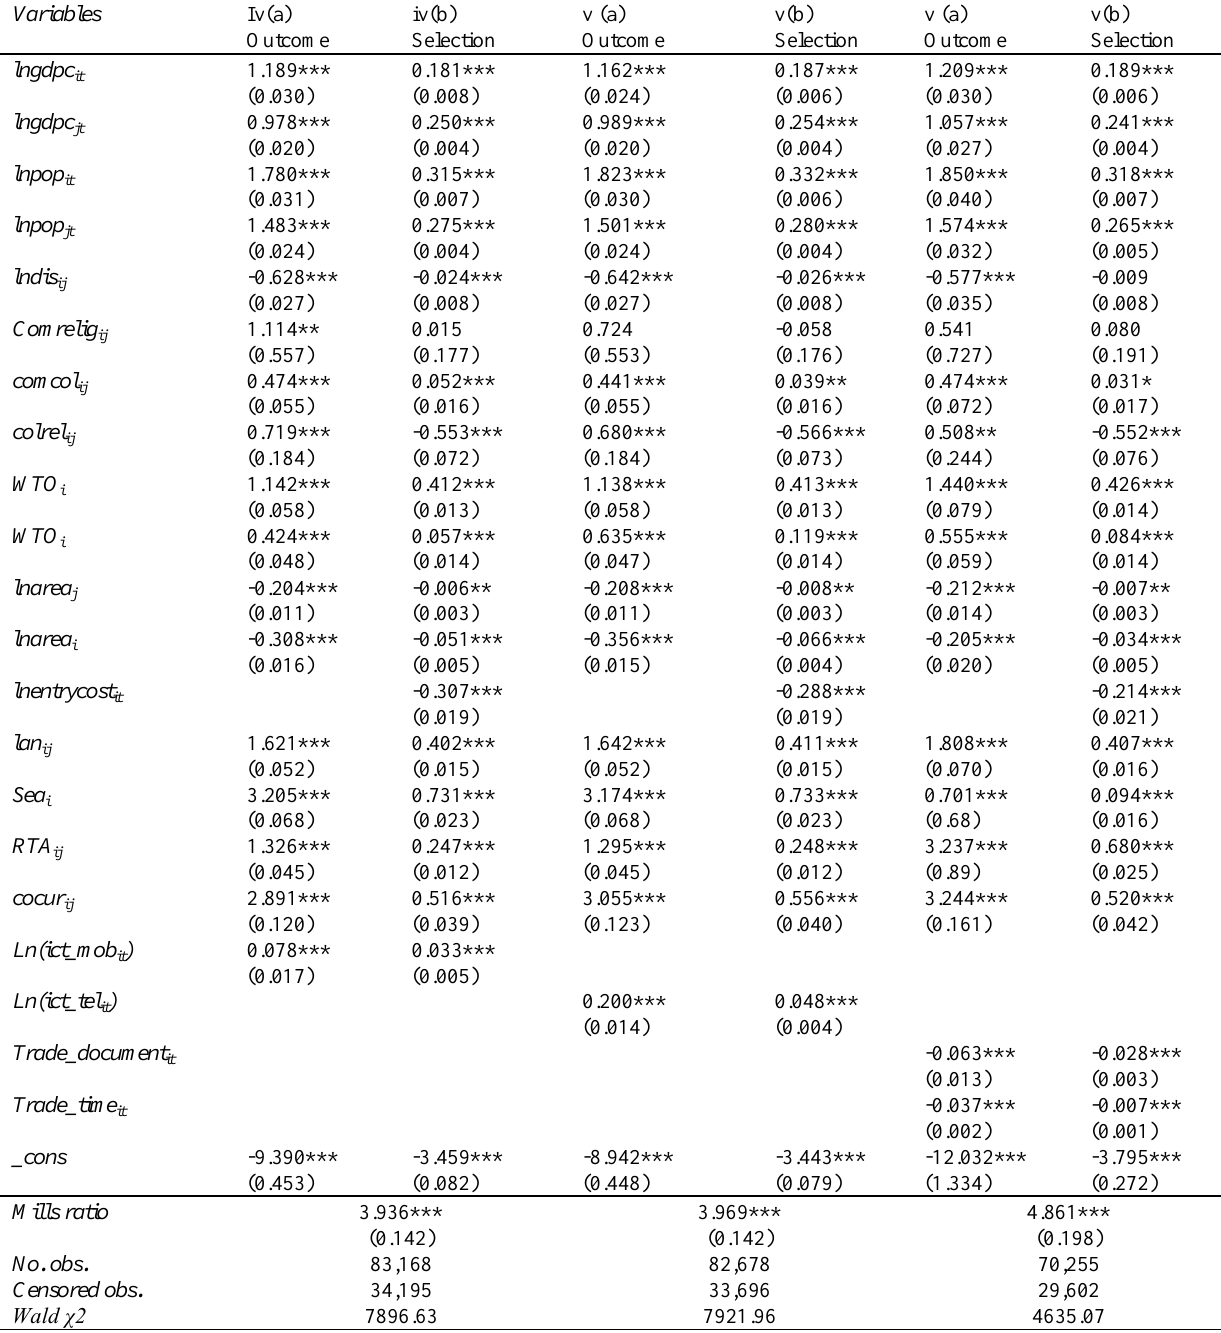
Table 11b : The impacts of separate border and transport efficiency and communication infrastructure on trade flow of African countries (twostep